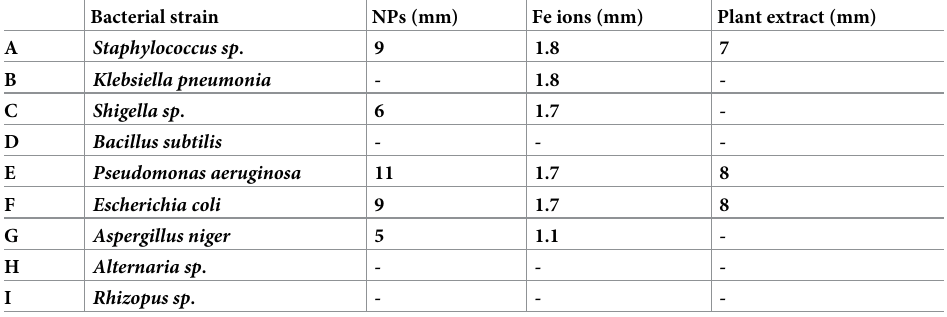
Table 1. The antimicrobial properties of (IONPs) obtained from S . costus root extract; the table displays the diam- eter of the inhibition zone (mm) around the hole. Bacterial strain NPs (mm) Fe ions (mm) Plant extract (mm) A Staphylococcus sp . 1.8 B Klebsiella pneumonia - 1.8 - C Shigella sp . D Bacillus subtilis - - - E Pseudomonas aeruginosa 11 1.7 F Escherichia coli 9 1.7 G Aspergillus niger 5 1.1 - H Alternaria sp . - - - I Rhizopus sp